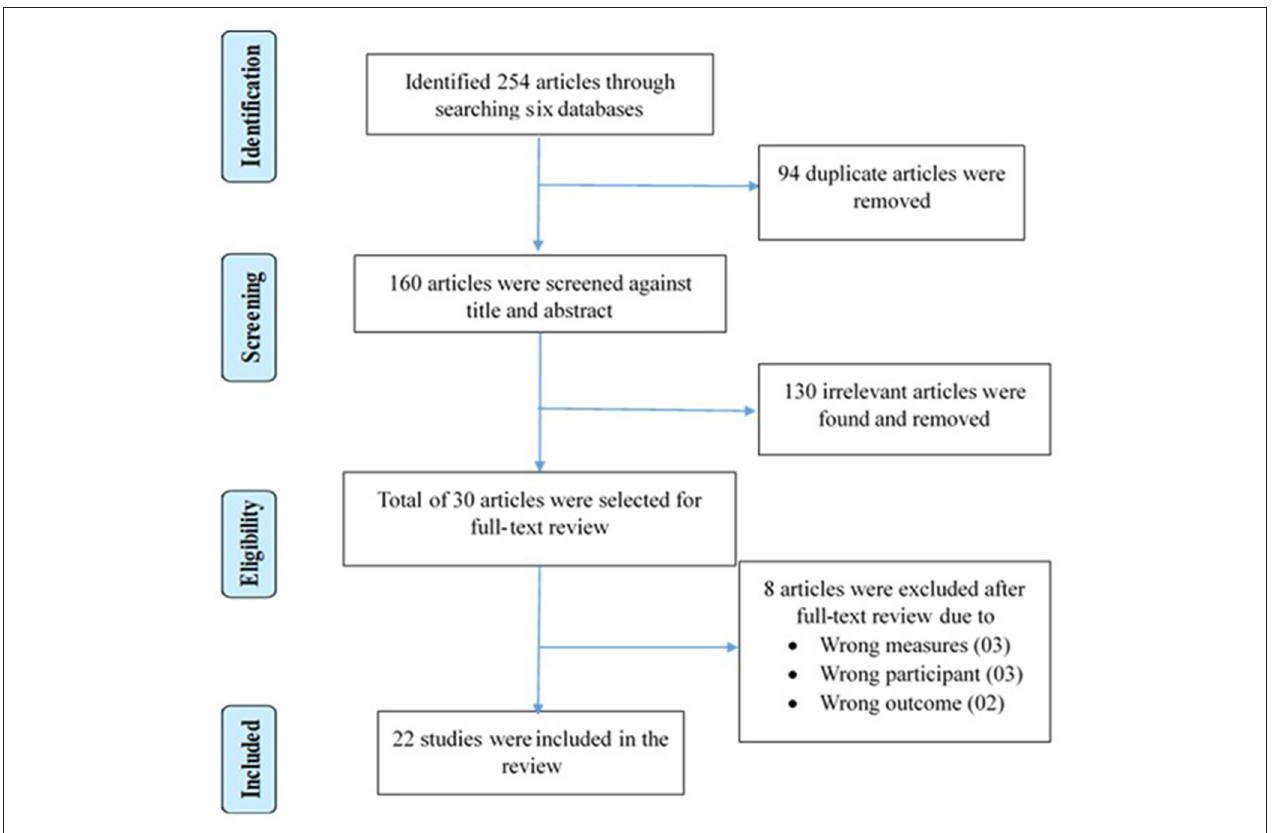
FIGURE 1 | PRISMA flowchart of the article selection